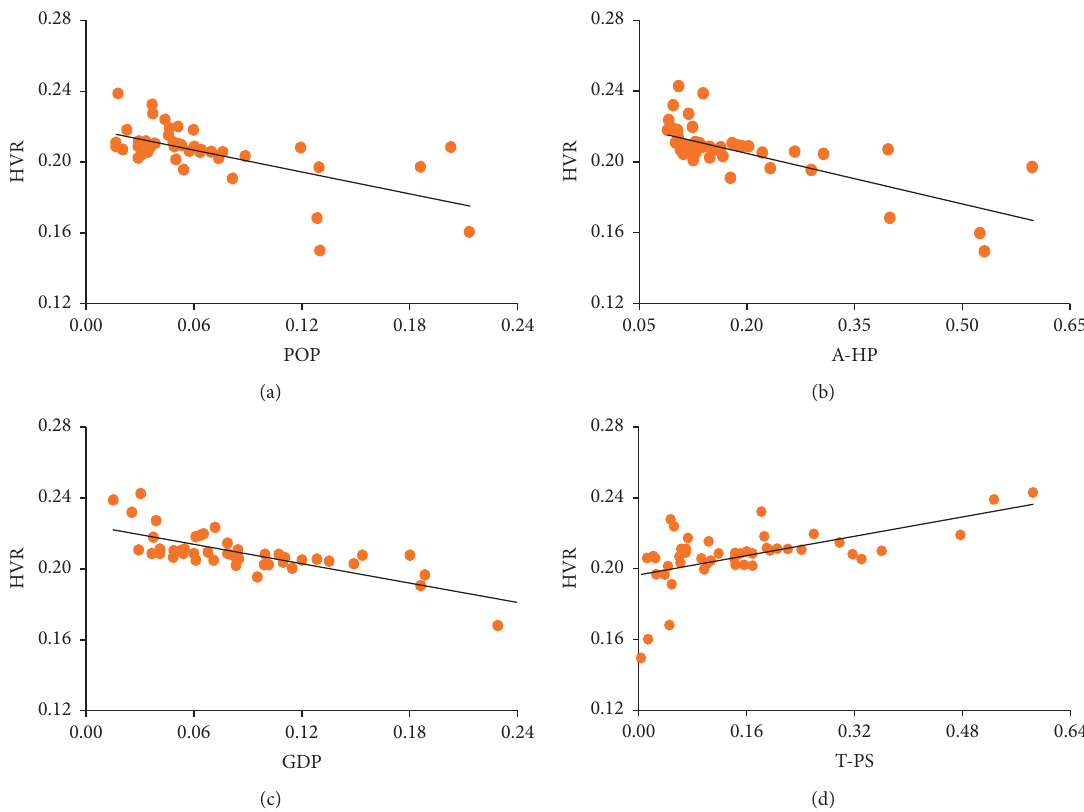
Figure 3: Correlation analysis between the HVR and standardized social factors: (a) population, (b) average housing price, (c) GDP, and (d) three production